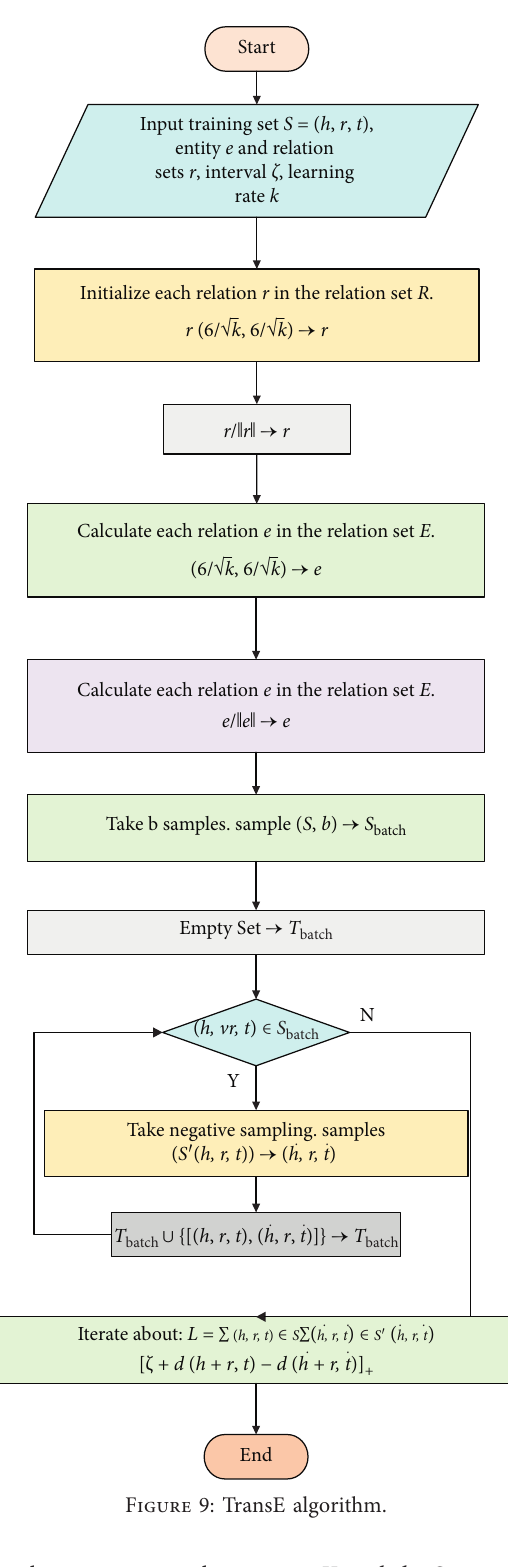
Figure 9: TransE